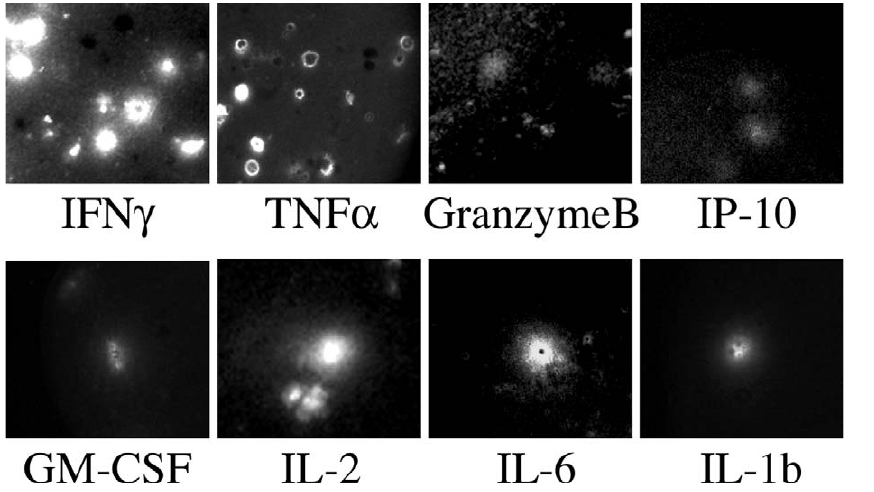
Figure 4. Anatomy of Cytokine Secretion Secreted cytokine captured as it is released from activated lymphocytes immobilized on a pMHC cellular microarray shows cytokine-specific configurations. Select representative patient samples are shown for each labeled cytokine to illustrate the patterns of secretion for each individual cytokine. DOI: 10.1371/journal.pmed.0020265.g004